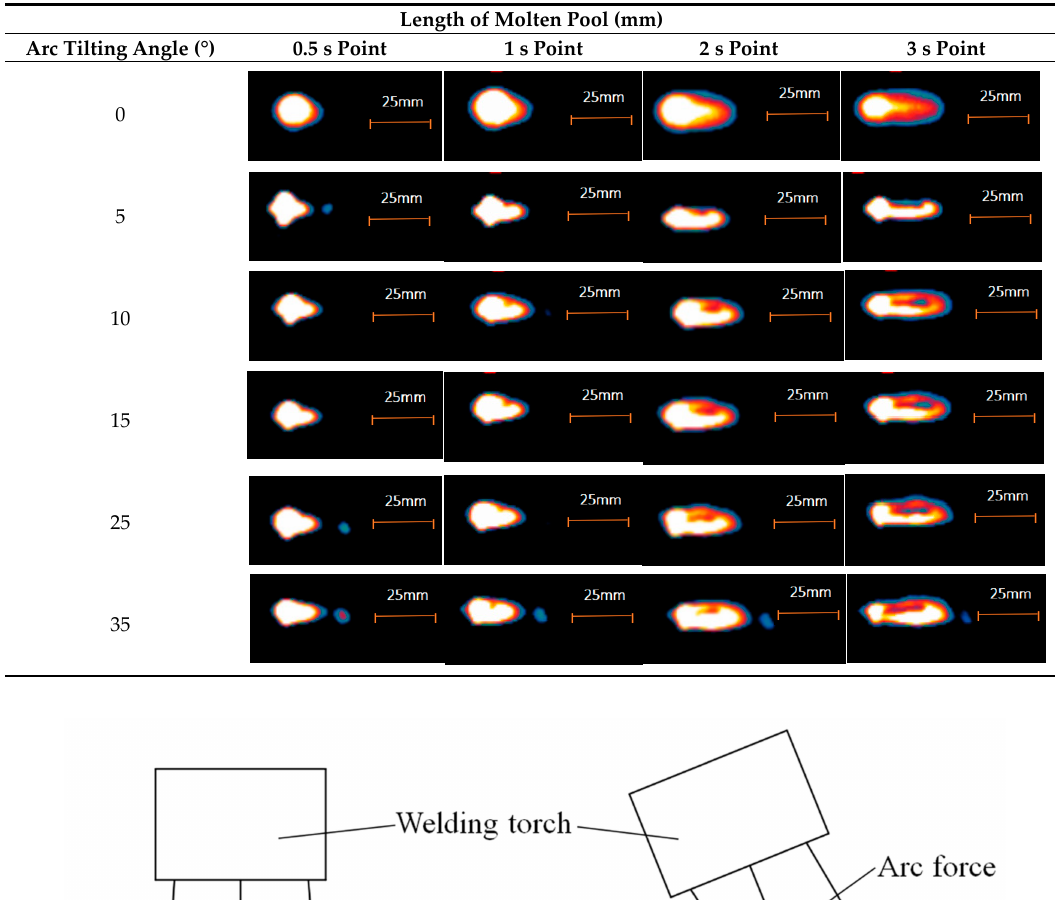
Table 3. Arc angle and length of the molten pool.